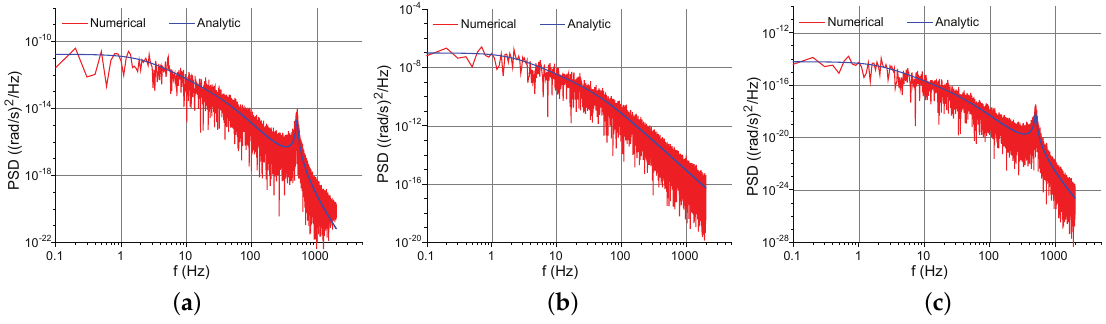
Figure 10. Numerically simulated and analytic PSD of the NER in the mode-split force-rebalance sense channel. ( a ) The mechanical NER; ( b ) The pickoff electrical NER; ( c ) The feedback electrical